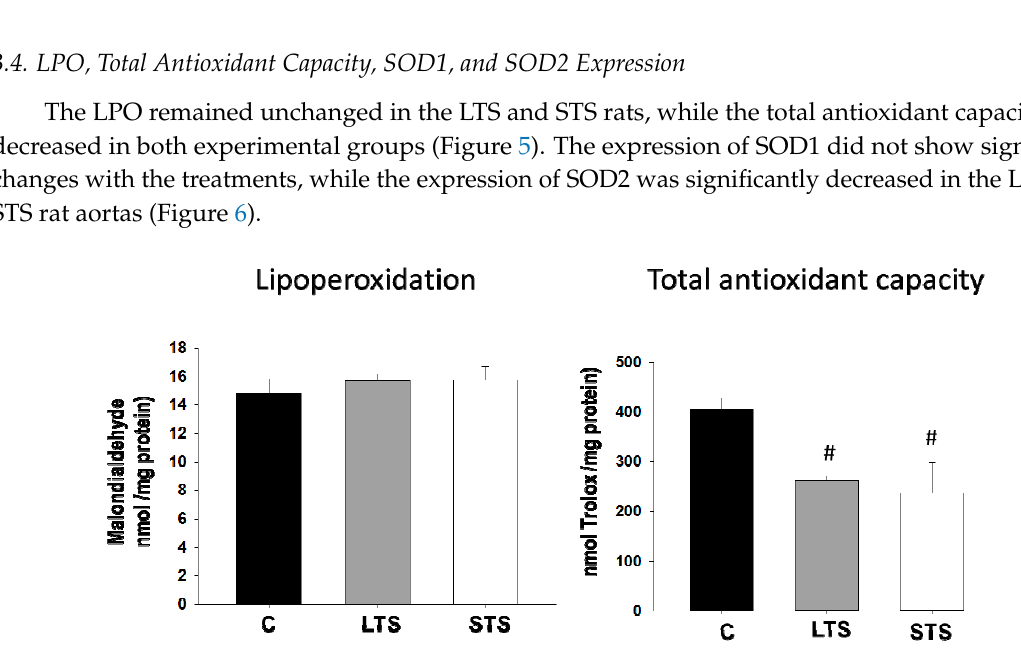
Figure 5. The effects of long-term (LTS) and short-term (STS) administration of sucrose on oxidative stress markers: lipoperoxidation (LPO) and total antioxidant capacity. Data represent mean ± SEM, # p < 0.05, n = 8 determinations from different rats in each group.